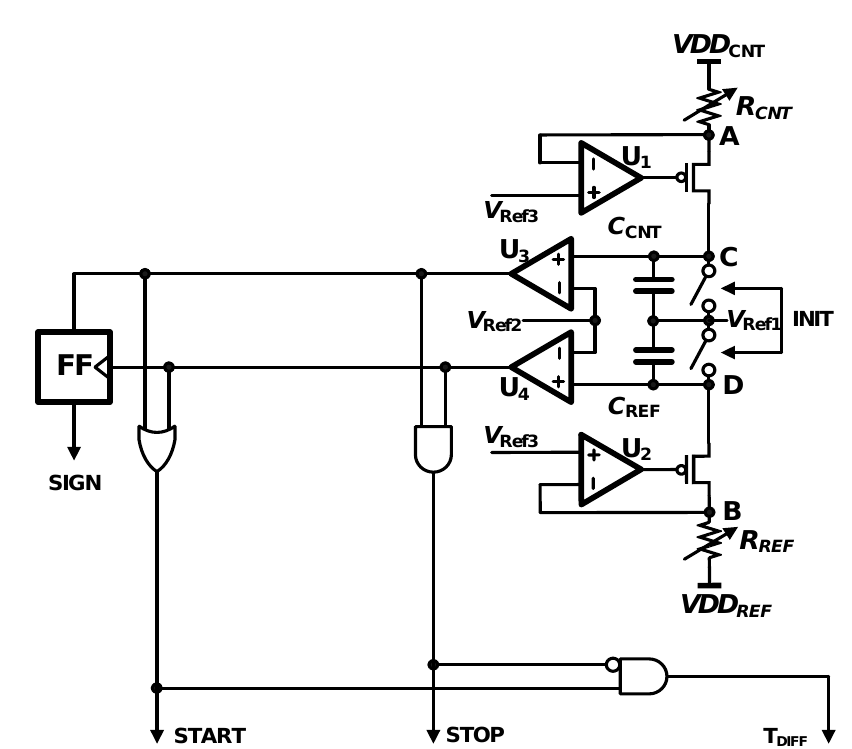
Figure 8. The analog-front-end circuit of the CNT ROIC used for measurement of the current across the CNT sensor